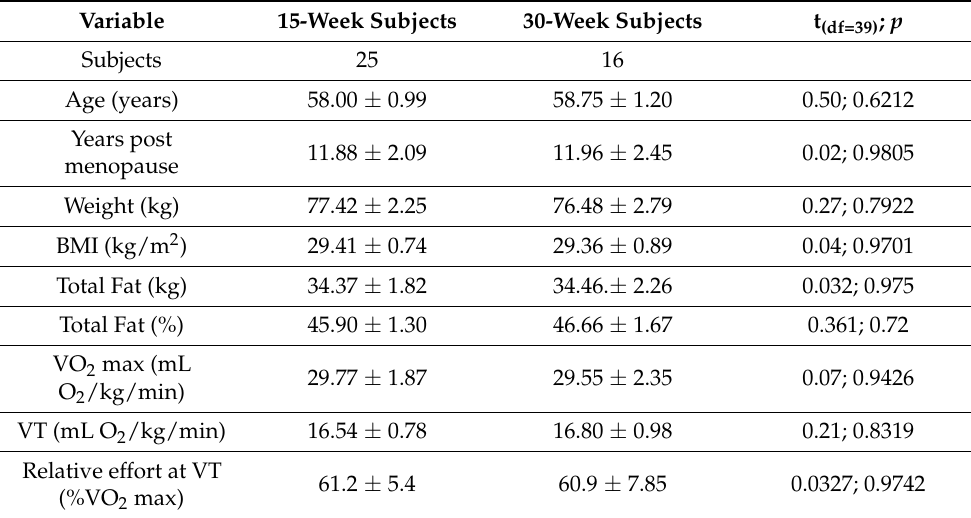
Table 1. Subject characteristics at baseline for the 15-week and 30-week